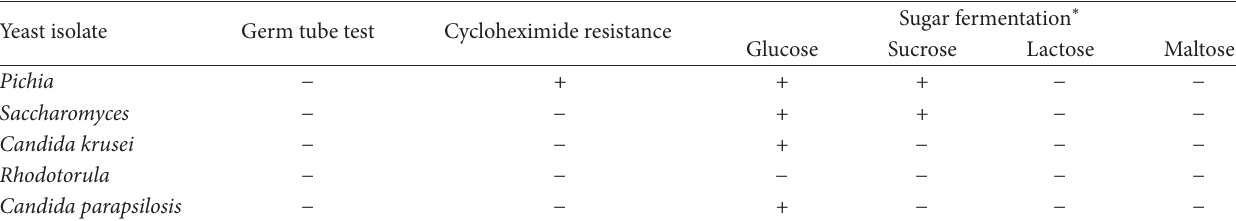
Table 5: Physiological tests for yeasts isolates of